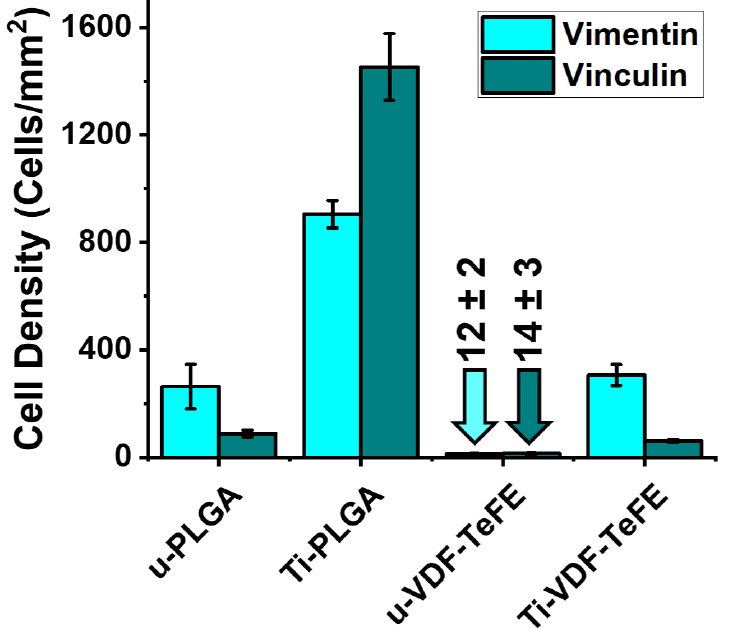
Figure 6. Number of cells per area (cells/mm 2 ) on u-PLGA, u-VDF-TeFE, Ti-PLGA and Ti-VDF-TeFE scaffold samples for both types of both utilized antibodies to labelling the primary human gingival fibroblasts with Alexa488 for fluorescence staining (vimentin — cyan, vinculin — teal). The better cell adhesion and proliferation on PLGA than on VDF-TeFE scaffolds is